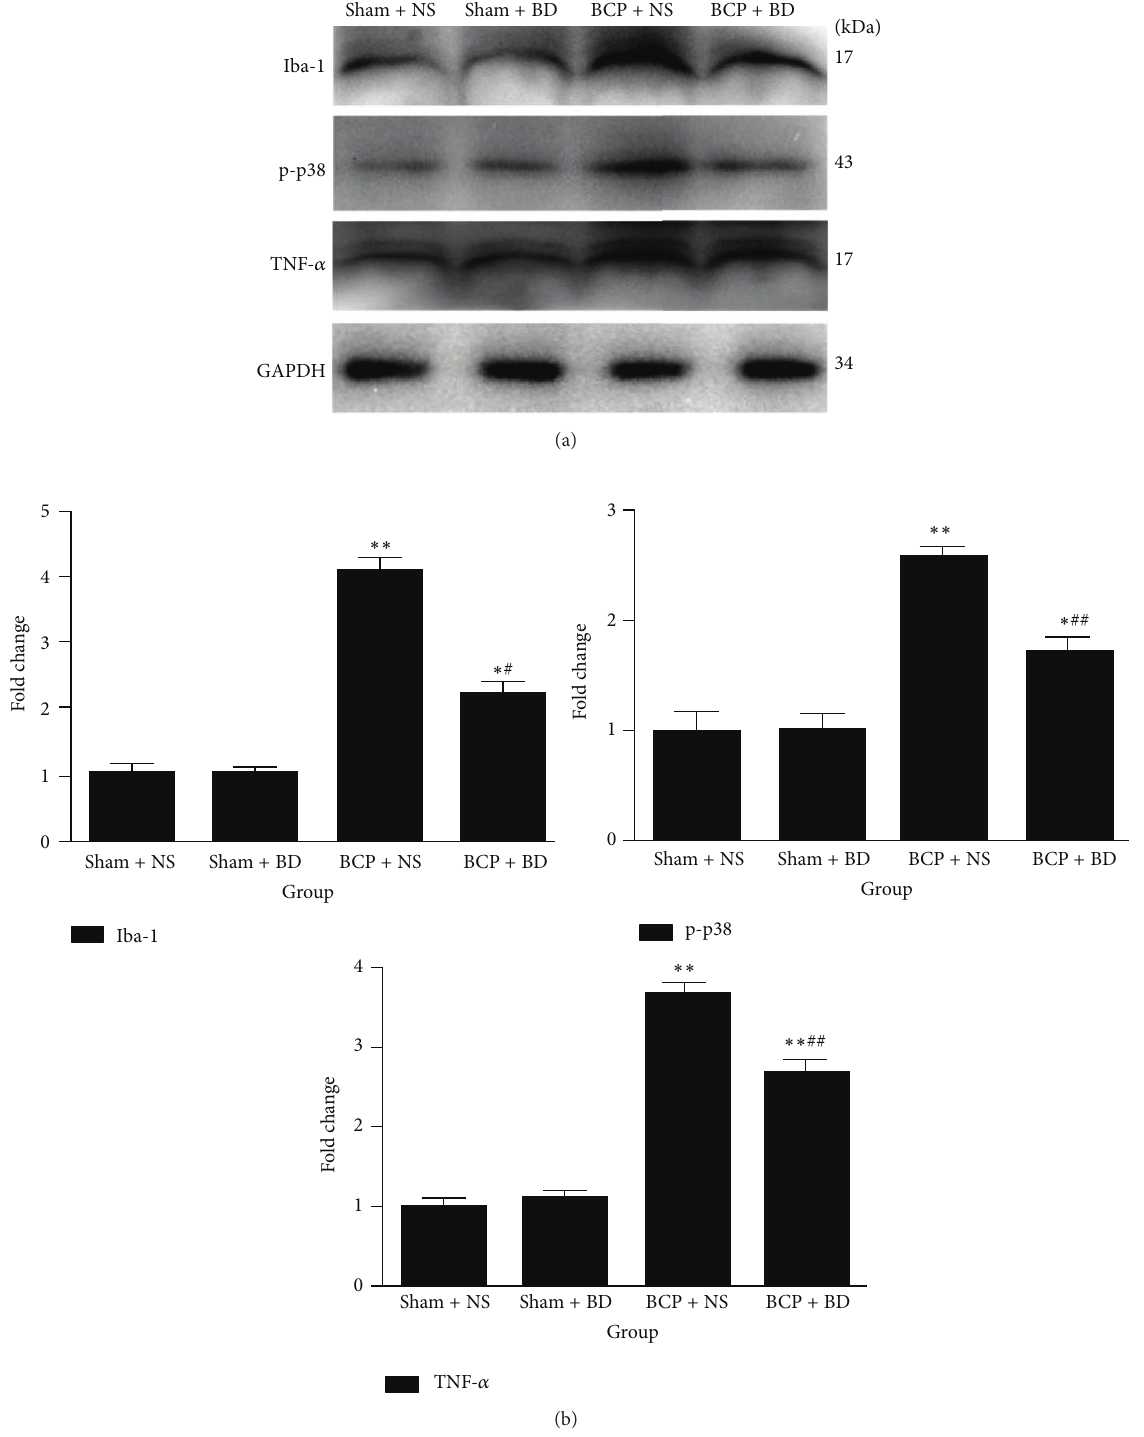
Figure 7: Iba-1, p38 activation. and proinflammatory cytokine expression were reduced by intrathecal administration of BD1047. (a) Western blot analysis indicated that Iba-1, p-p38, and TNF- 𝛼 expression were higher in the spinal cord of BCP rats on day 7. Intrathecal BD1047 significantly reduced the expression of these molecules in BCP rats compared with NS-treated BCP group. (b) Quantification of Iba-1, p-p38, and TNF- 𝛼 expression level in the spinal cord ( 𝑛 = 4 ). Results are given as means ± SEM. ∗ 𝑃 < 0.05 , ∗∗ 𝑃 < 0.01 versus sham + NS group; # 𝑃 < 0.05 , ## 𝑃 < 0.01 versus BCP + NS